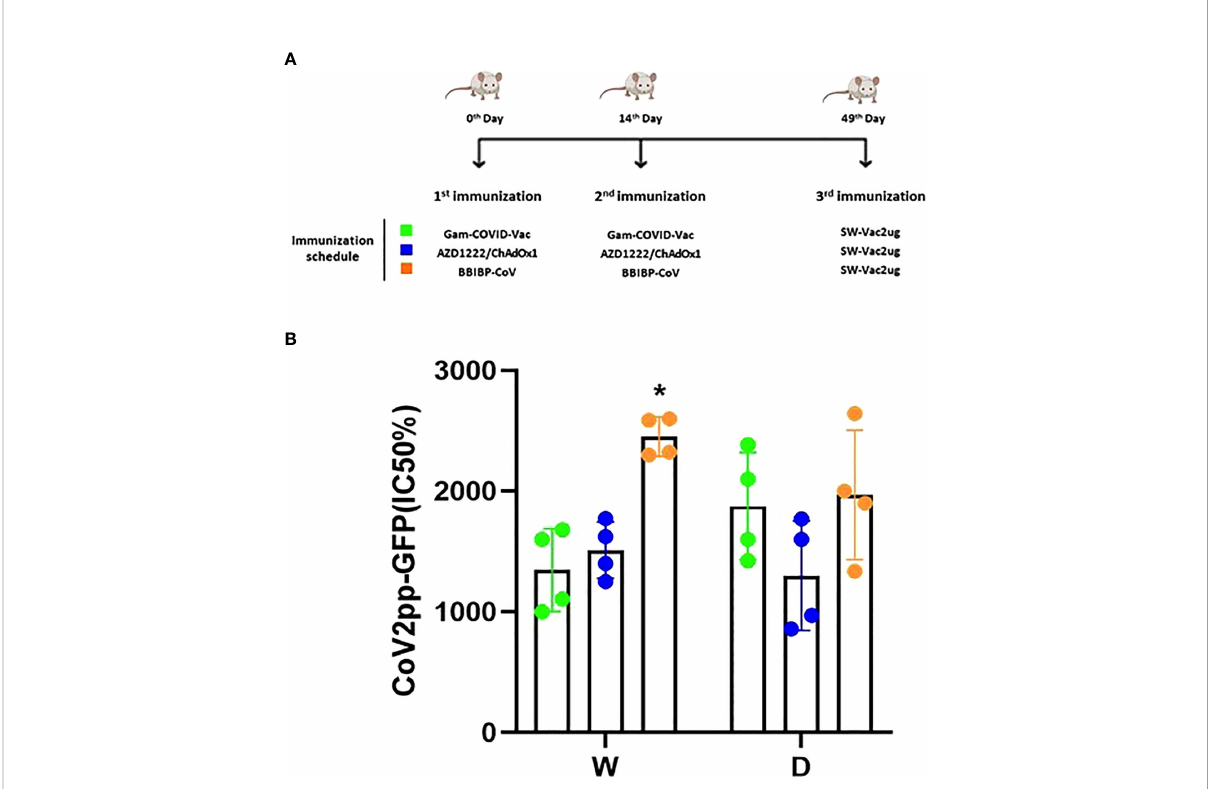
FIGURE 8 Neutralizing capacity induced by a booster with SW-Vac 2µg formulation. BALB/c mice (n=4/group) were immunized on Days 0 and 14 with commercial Gam-COVID-Vac-rAd26/rAd5, AZD1222/ChAdOx1 or BBIBPCorV vaccines plus a booster with SW-Vac formulation delivered intramuscularly (A) . Serum was collected on Day 14. Neutralizing titers were measured by 50% inhibition for the pseudotyped virus (CoV2pp- GFP) in immunized (B) . Absolute inhibitory concentration was calculated as the corresponding point between the 0% and 100% assay controls. Fifty % inhibition was de fi ned by the controls for all the samples on the same plate. For statistical analysis, values were analyzed by a one-way ANOVA with Bonferroni`s multiple comparisons test.